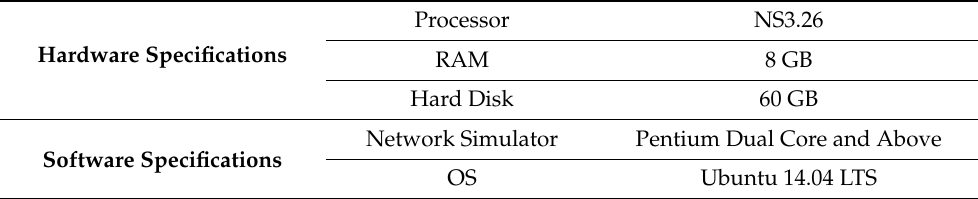
Table 4. System configuration.